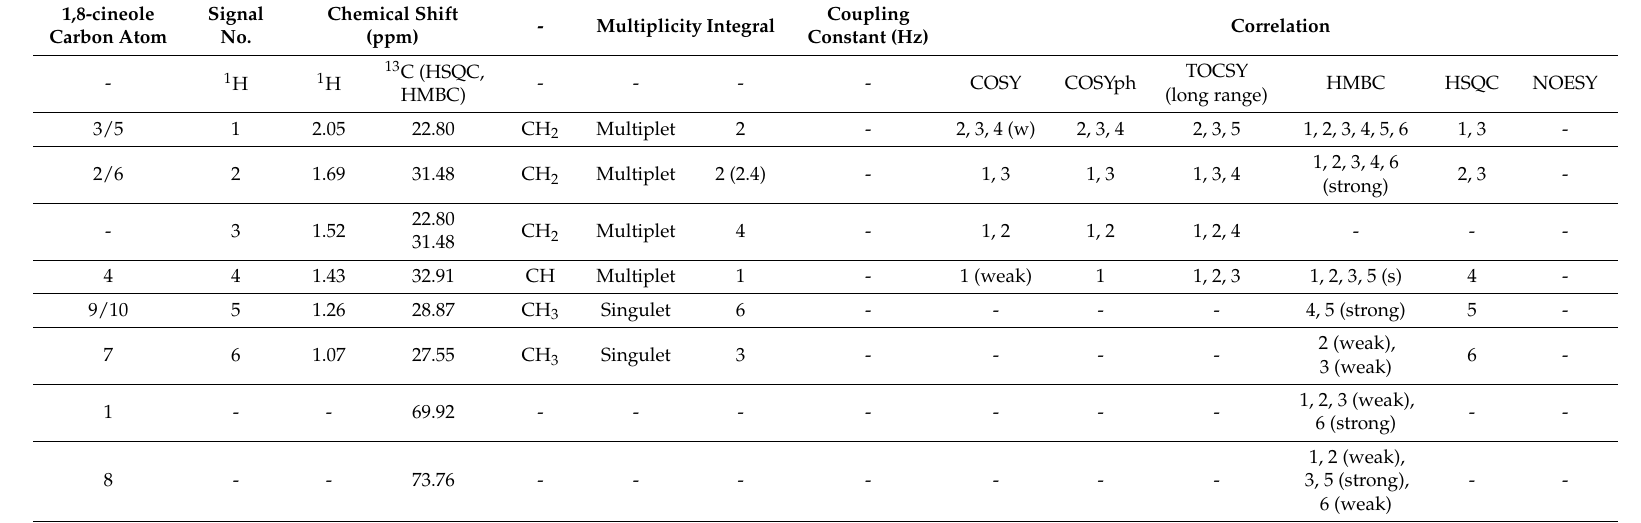
Table 2. NMR Signal assignment for